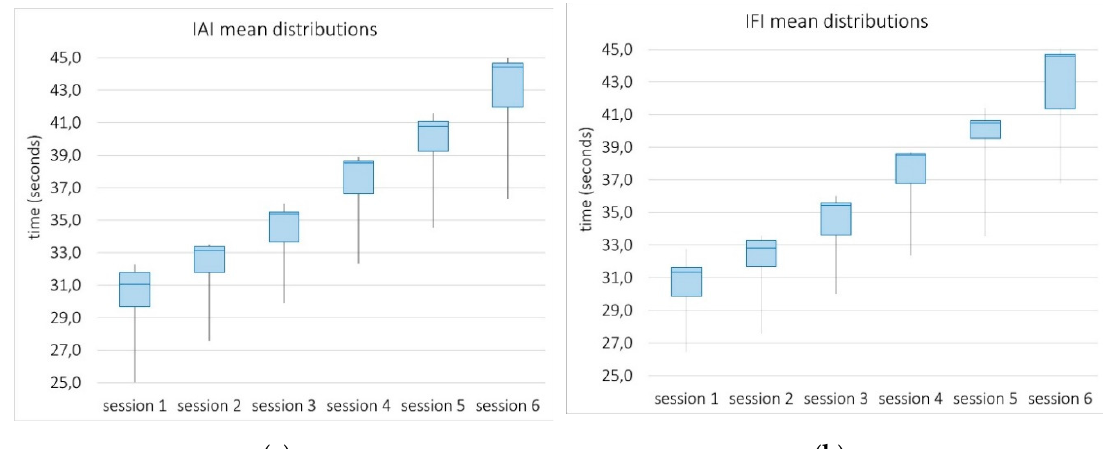
Figure 8. Box plots from distributions of the mean values of the Isometric Abduction Index ( a ) and the Isometric Flexion Index ( b ) across patients over the six sessions. These measures ranges from 0 to 45 seconds, with the latter being the goal established in this study.